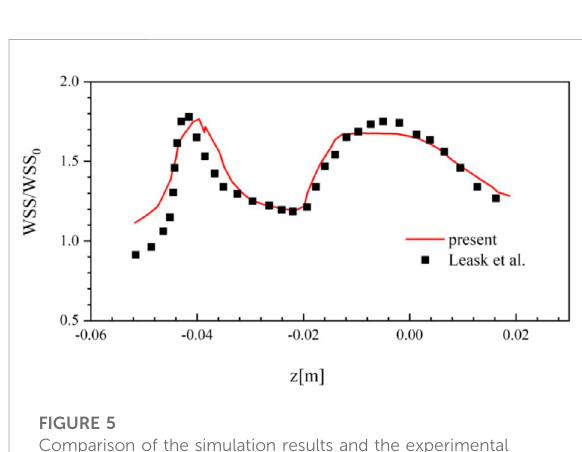
FIGURE 5 Comparison of the simulation results and the experimental